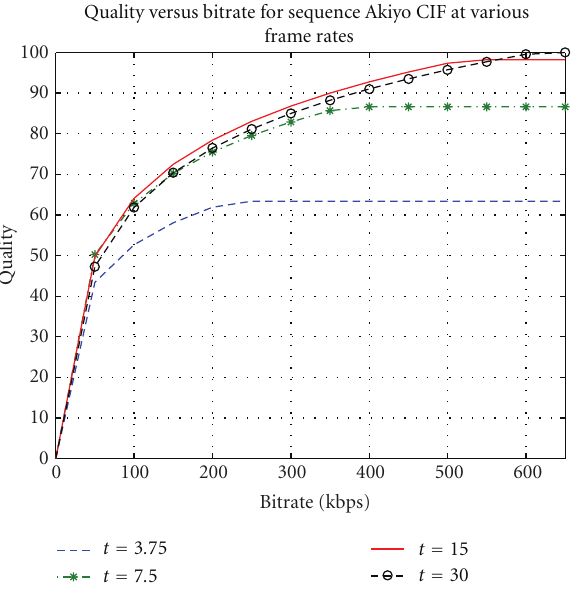
Figure 6: Quality versus Bitrate for sequence Akiyo CIF at various frame